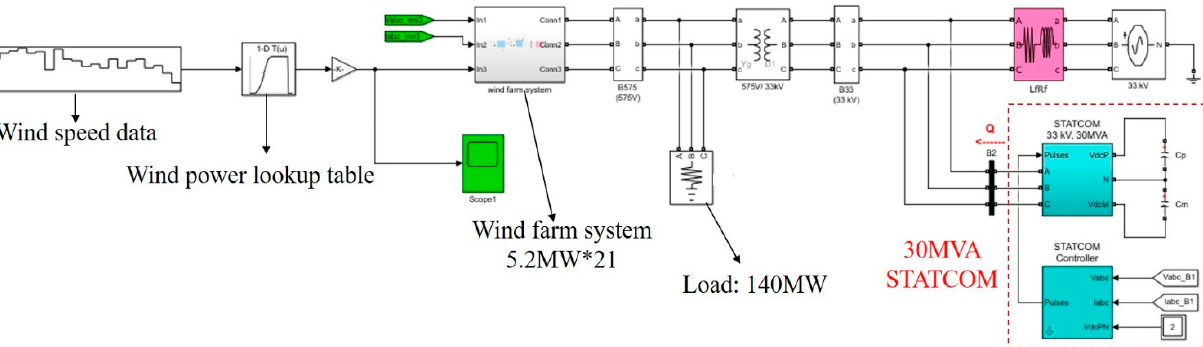
Figure 17. Single-line diagram of the offshore wind farm and STATCOM system under study.